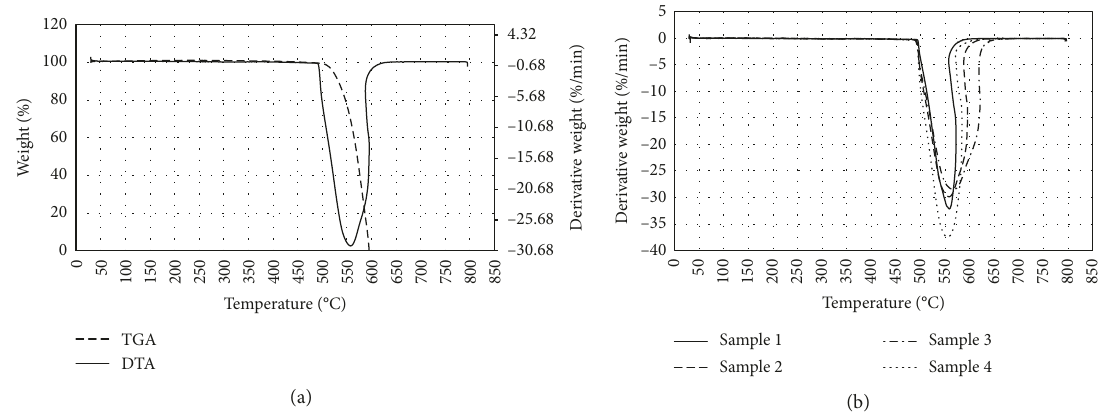
Figure 2: Plots of (a) TGA and DTG curves and (b) DTG curves for different heating